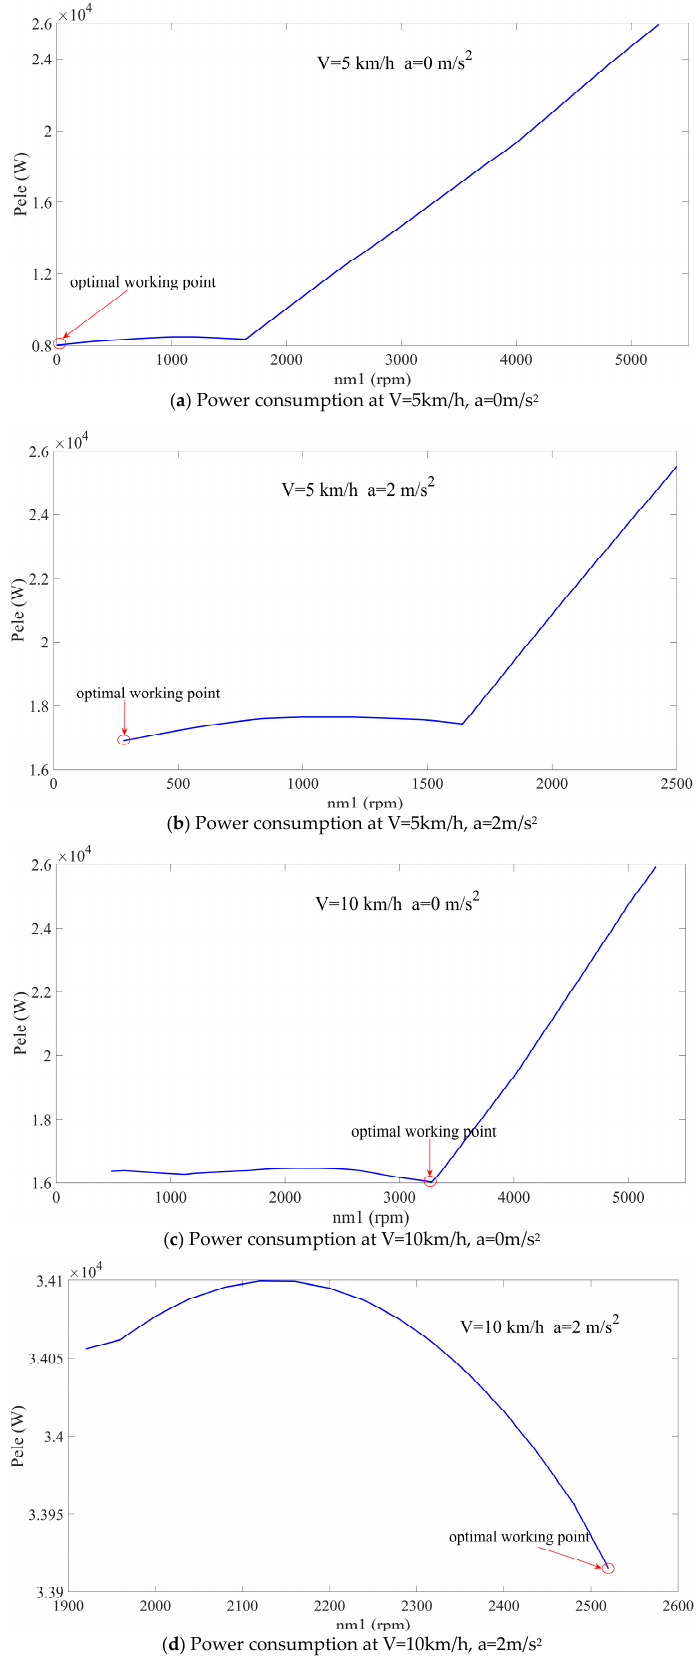
Figure 5. The objective function under different driving conditions (PDR = 0.65, k = 2.6, SOC = 60).